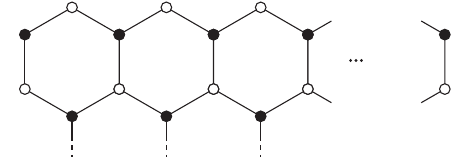
FIG. 3. Periodic boundary condition in y direction.